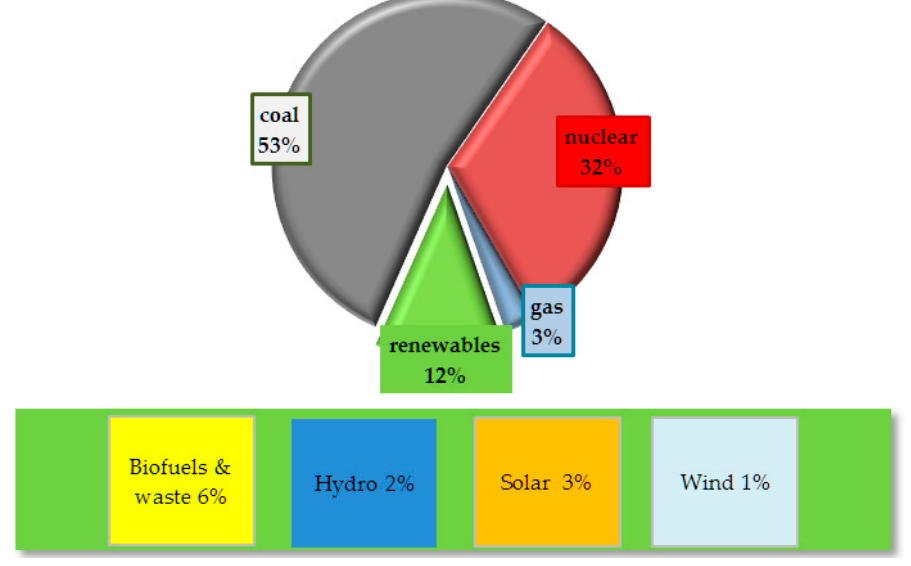
Figure 3. Distribution of energy sources on electricity generation in Czech Republic based on [41].